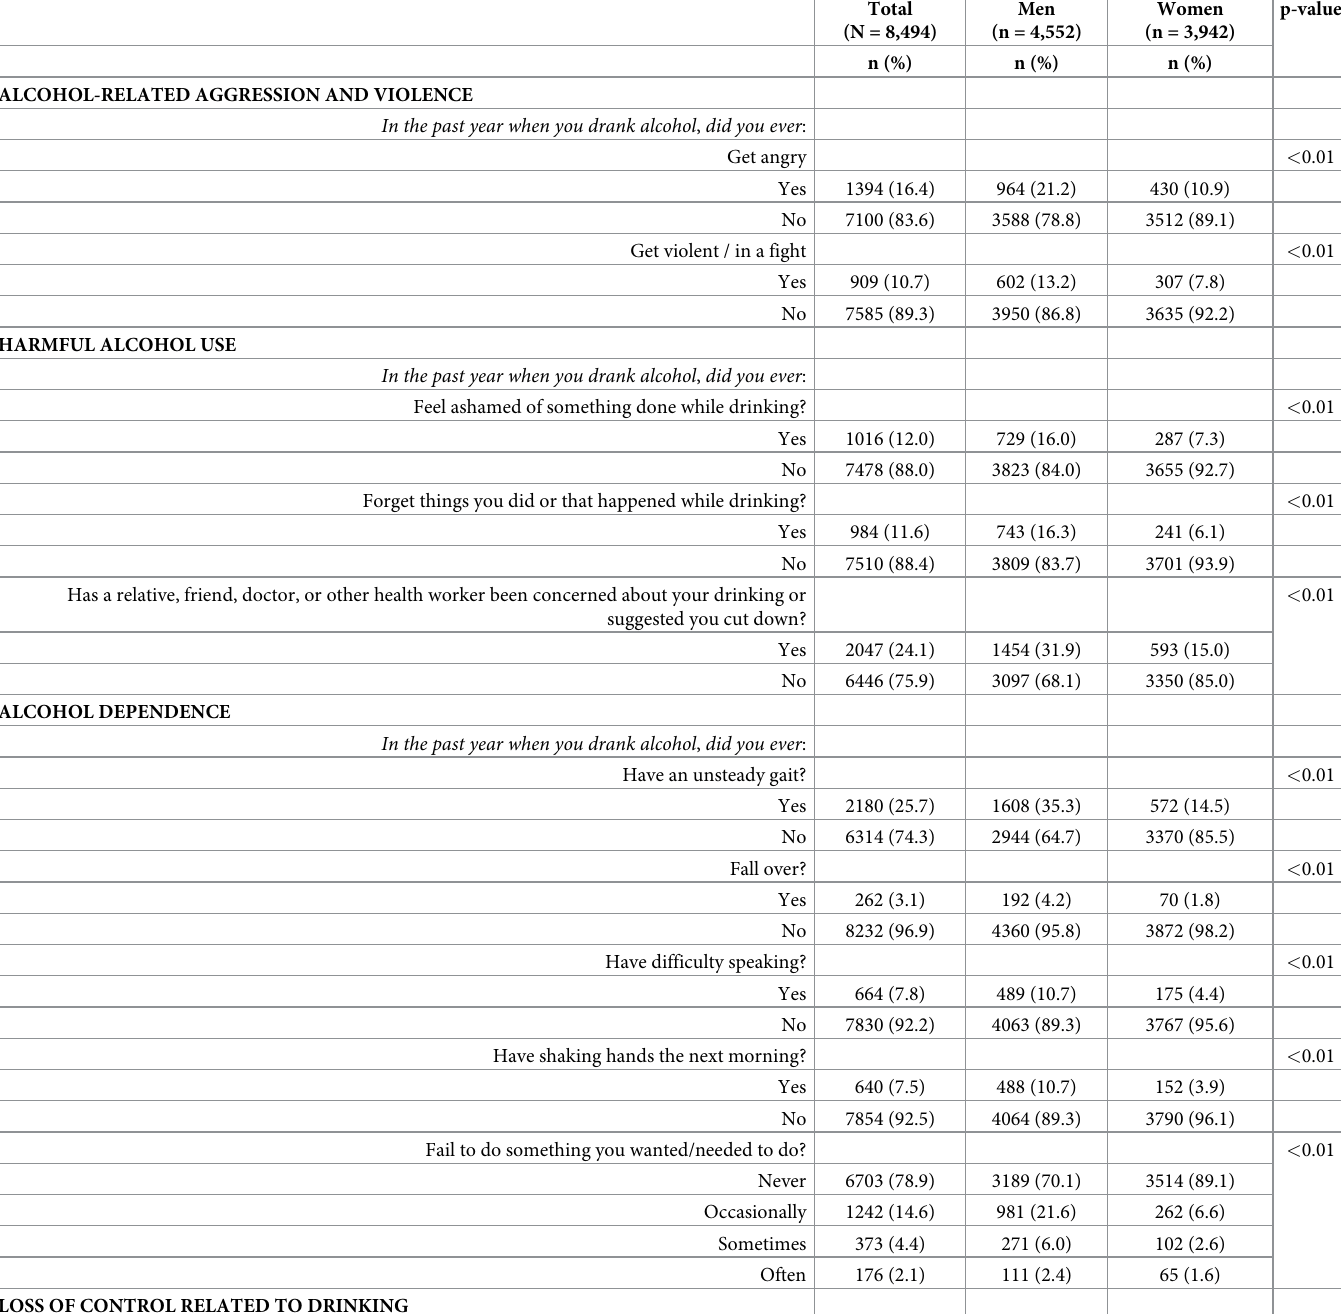
Table 5. Consequences of alcohol consumption among men and women who participated in RCCS between March 2015 and September 2016 and reported past year